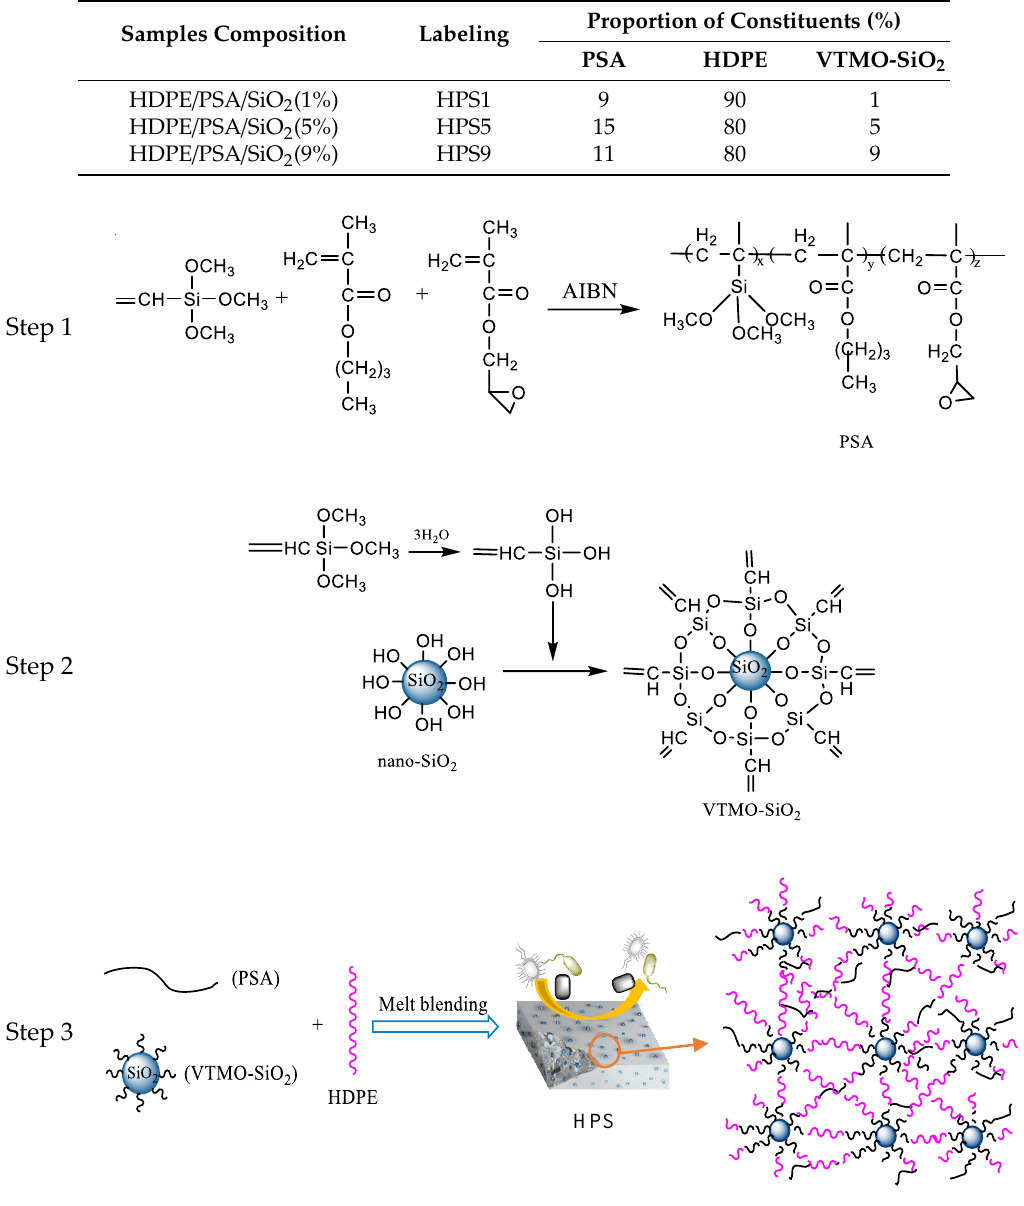
Figure 2. The preparation procedure for the HDPE/PSA/SiO 2 composite. Table 2. Different mixture ratios for the composite preparation.